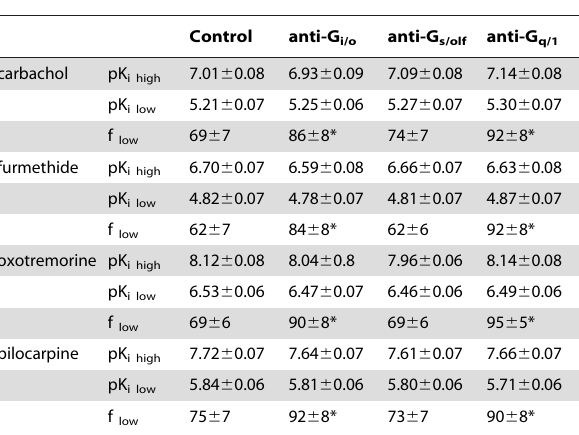
Table 3. Effects of IgG antibodies directed against a -subunits of individual subtypes of G-proteins on binding parameters of different muscarinic agonists in membranes of M 1 CHO cells.